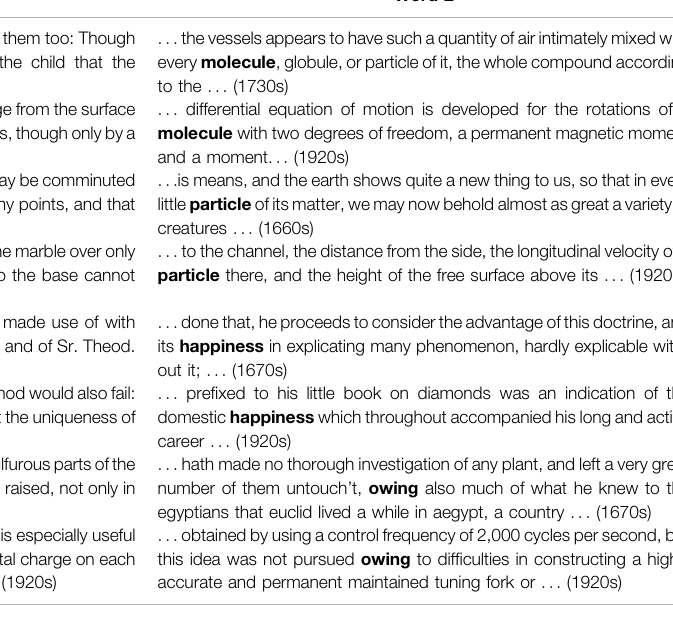
TABLE 2 | Examples of word pairs with changing cosine similarity over time. We present three cases of increasing distance (indicating diversi fi cation) and one case of decreasing distance (indicating conventionalization). Word pair Word 1 Word 2